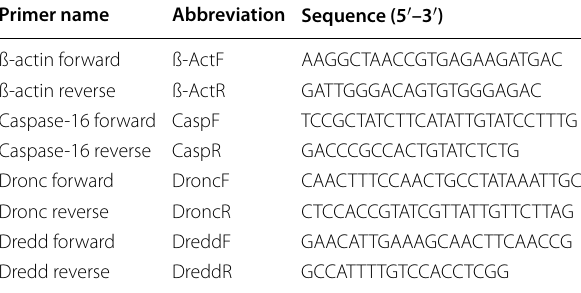
Table 1 Primer sets for real‑time quantitative PCR experiments that measure the expression levels of genes related to apoptosis Primer name